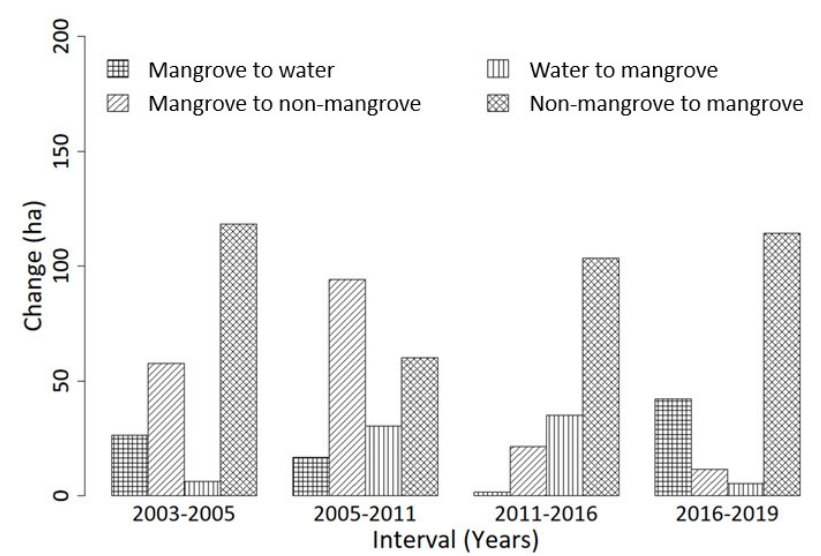
Figure 6. Progressive change in land-cover (in hectares) at image acquisition intervals.